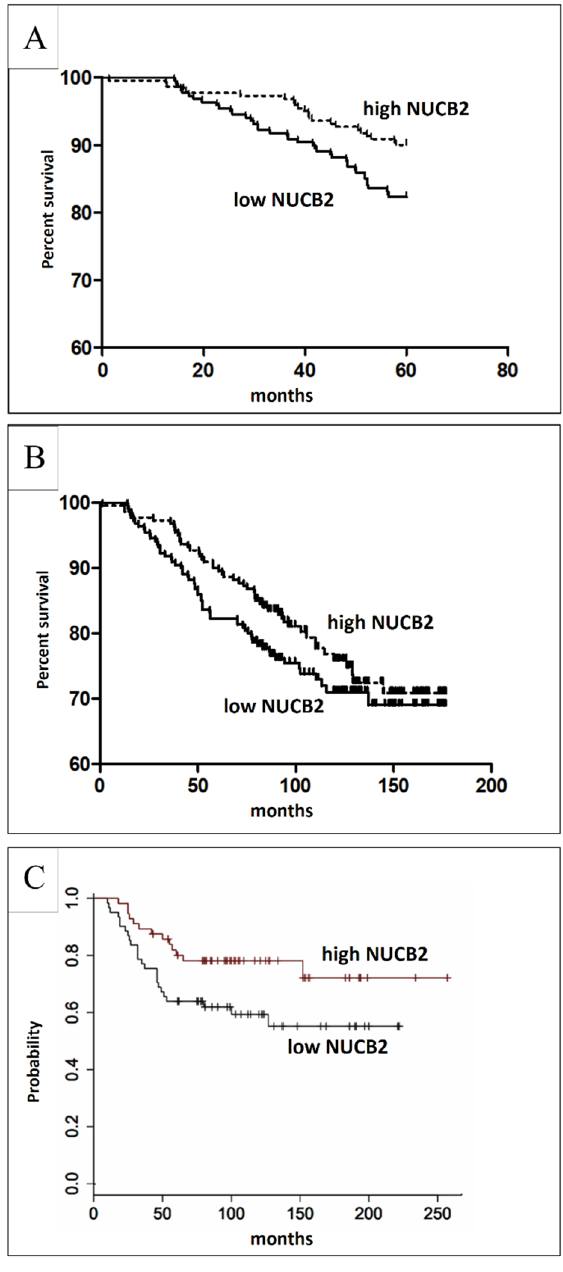
Figure 6. Survival analysis of the NUCB2 protein. ( A ) A higher level of NUCB2 expression strongly correlated with a higher five-year survival rate ( p = 0.0187). ( B ) NUCB2 expression showed no significant association with overall survival ( p = 0.2182). ( C ) Survival analysis was performed with an online analysis tool on 2032 cases of BC ( p = 0.032) [31]. The good prognostic effect of high NUCB2 expression was related to longer overall survival.